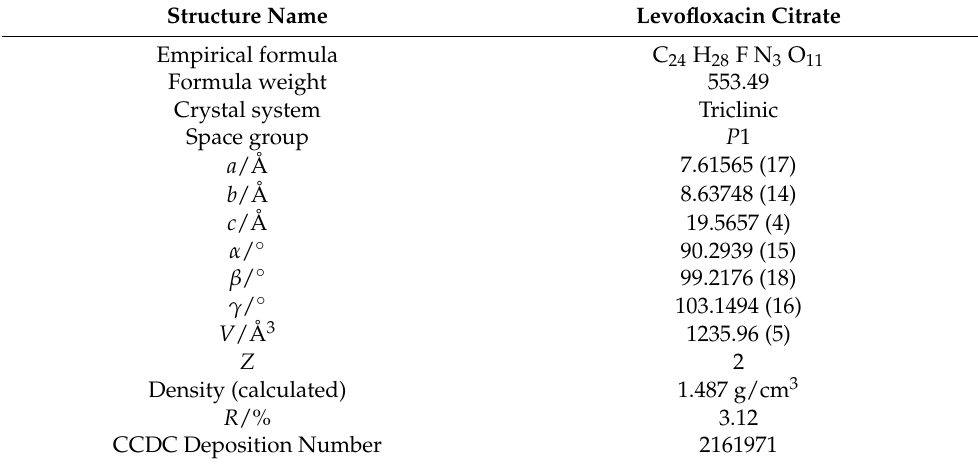
Figure 8. Empirical structure of levofloxacin-citrate/LC ( A ); the different C-O distance of ionized citric acid in the LC structure ( B ); ORTEP-3D structural drawing of LC with the hydrogen bonds in blue ( C ); and the calculated compared to the measured diffractogram of LC ( D ). Table 1. Crystal data of